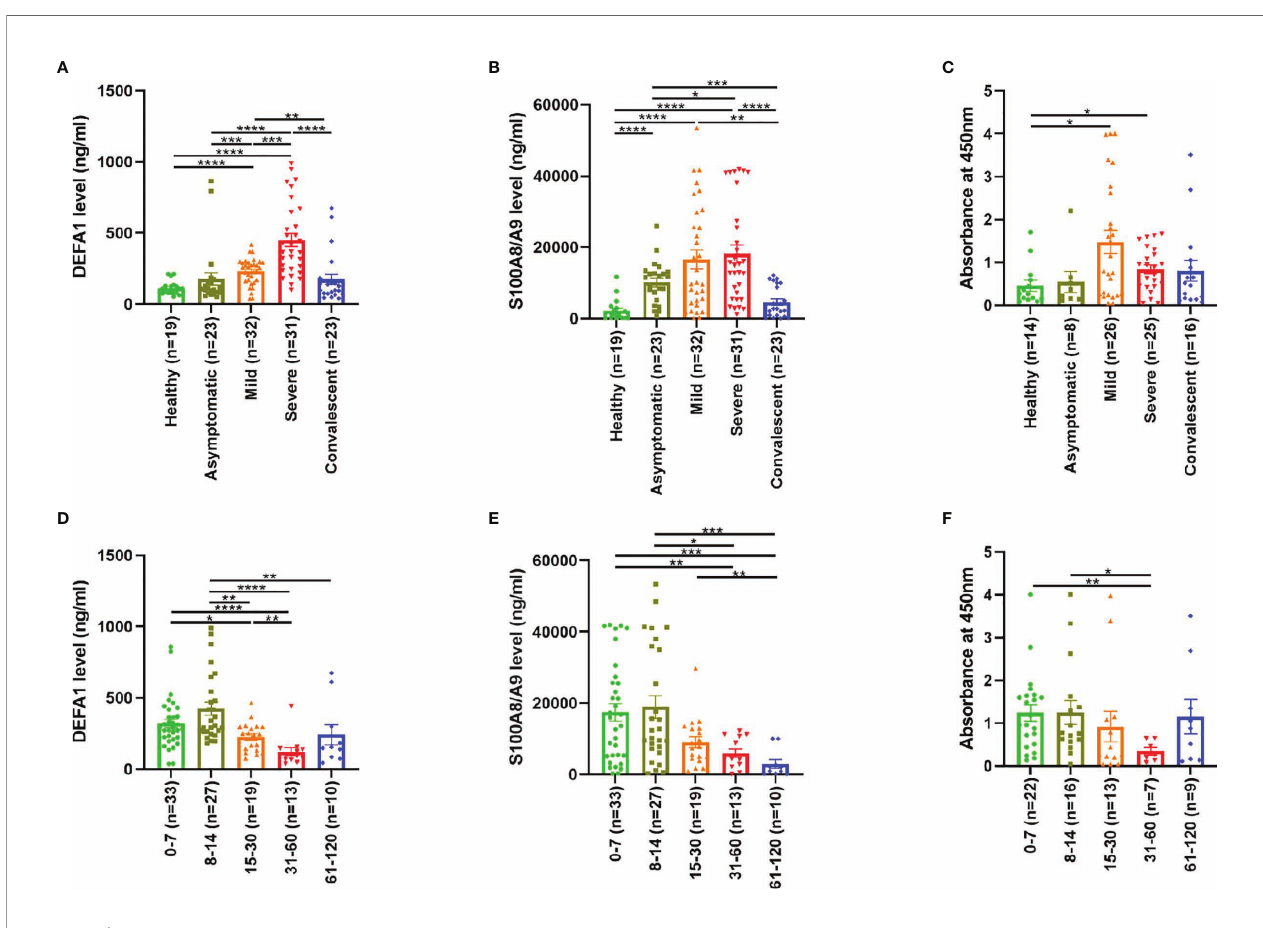
FIGURE 1 | Expression levels of neutrophil activated proteins in sera/plasma of COVID-19 patients. Levels of (A) DEFA1, (B) S100A8/A9 and (C) MPO in COVID-19 patients with different clinical presentations in comparison to healthy controls. Figures D-F depict modulation of (D) DEFA1, (E) S100A8/A9 and (F) MPO levels in COVID-19 patients on different days post onset of disease (POD). The data is presented as dot plots with bar representing the mean ± SEM in each group. Each dot represents a single sample. P values were calculated using Mann-Whitney test. * denotes p-value < 0.05, ** denotes p-value < 0.01, *** denotes p-value < 0.001 and **** denotes p-value <